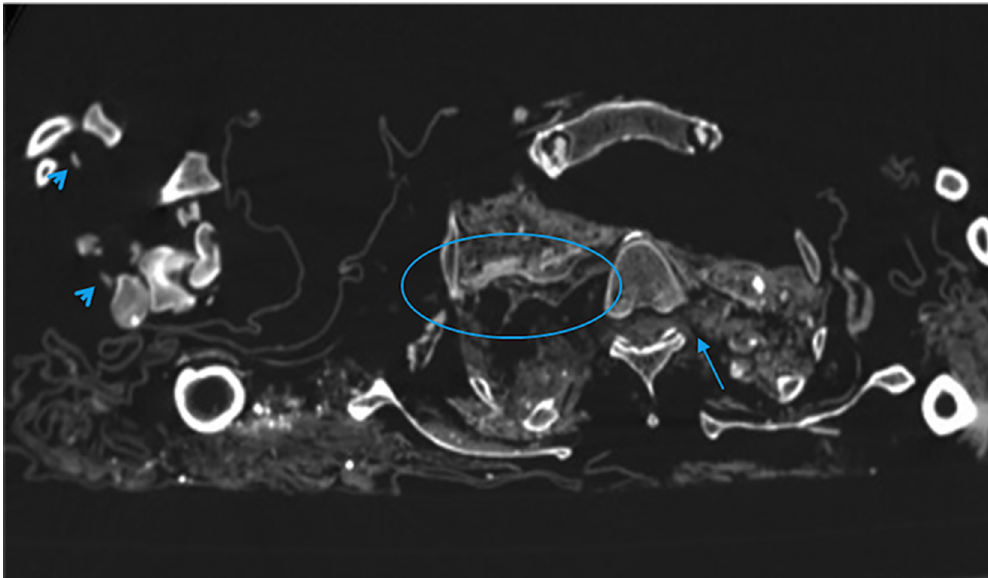
Fig 4. Soft tissues of the trunk without a clear anatomical identity. The tubular structure on the right side of the vertebral body may be residual of mediastinal organ, such as trachea (white circle). Residual of spinal medulla with left radicular emergence (arrow). Flexor tendons of right hand (arrow-heads). Multiple hyper attenuated inclusions, maybe related to little rocks, can be observed in axial